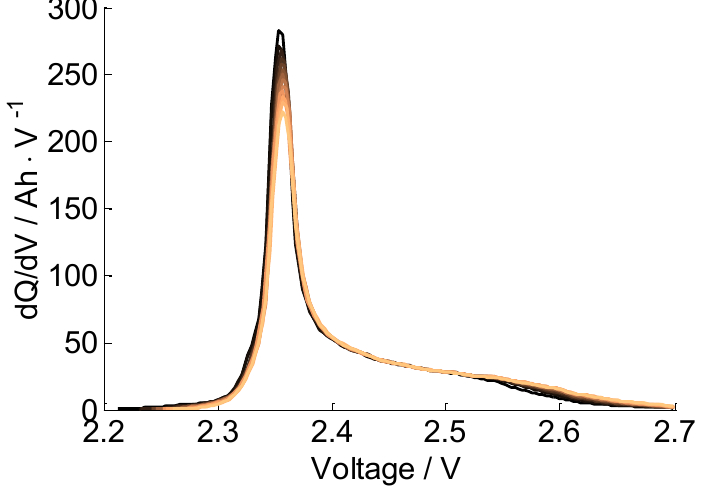
Figure 10. The IC curves of Cell B after every 90 cycles up to 1080 cycles; with cycle number increase, line color changes from black to